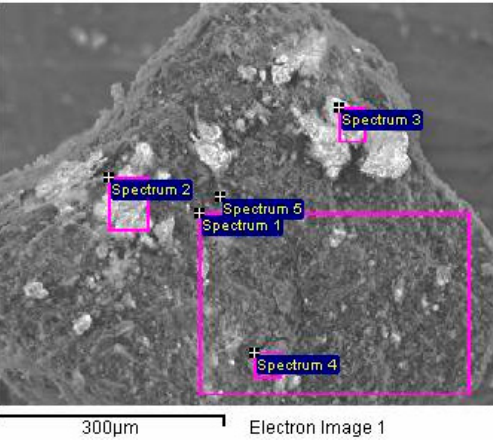
Figure 3. EDS-SEM micrography of waste slag. Table 7. Composition of the slag surfaces at selected positions expressed in weight percentages (wt.%). Element Concentration Spectrum Number